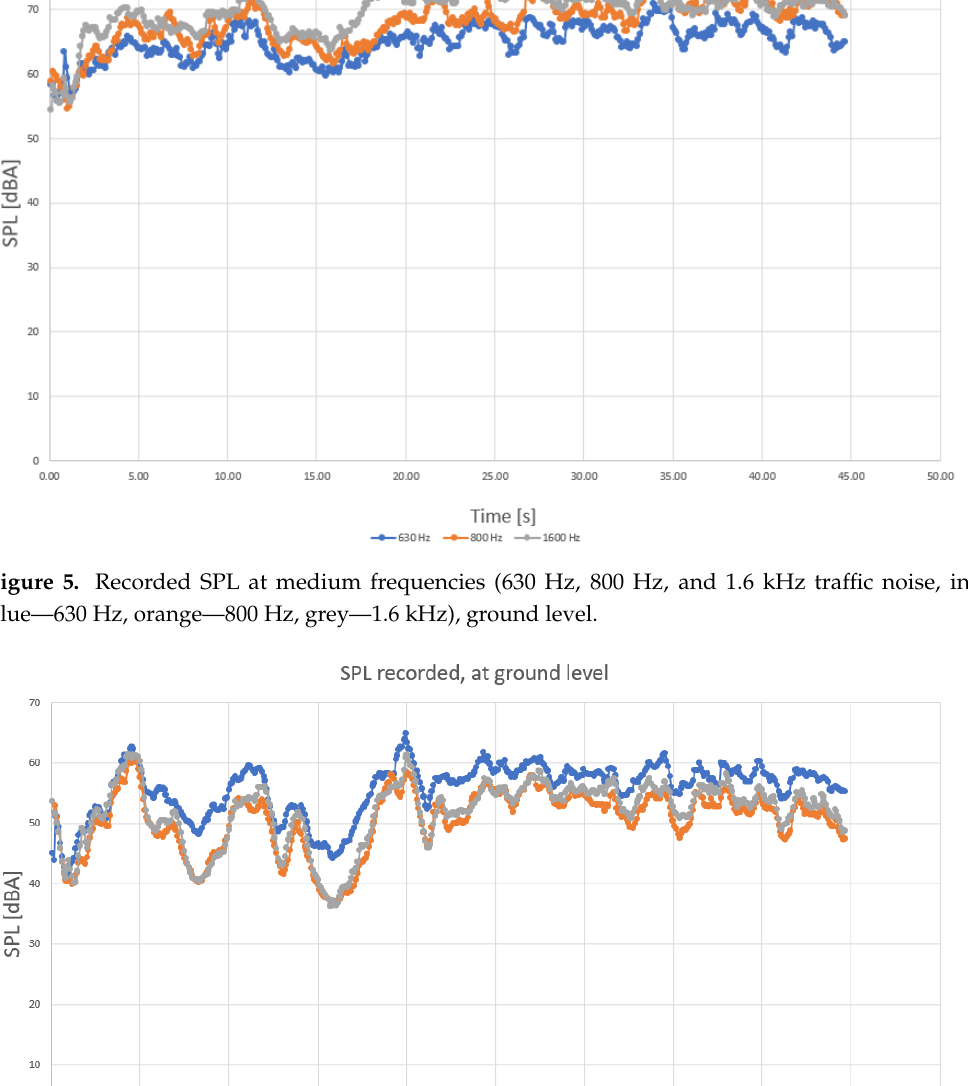
Figure 4. SPL variation recorded in lower frequency range (50 Hz, 80 Hz, and 125 Hz traffic noise), ground level: blue—50 Hz, orange—80 Hz, and grey—125 Hz.